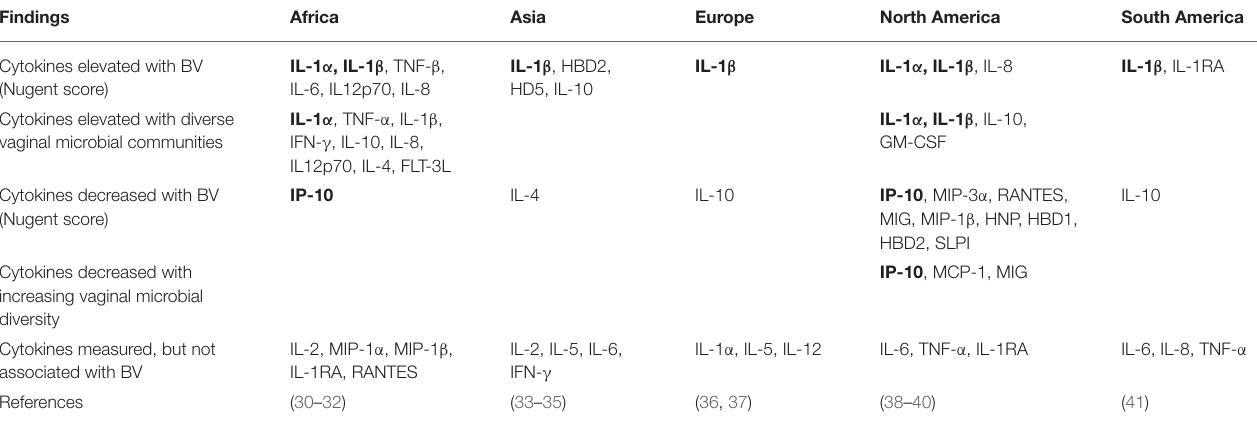
TABLE 1 | Associations between vaginal immune markers and microbiota in cross-sectional studies of non-pregnant, HIV-uninfected women.